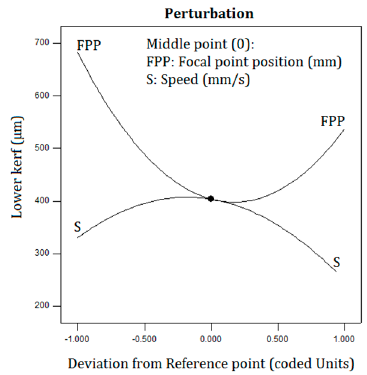
Figure 10. Perturbation plot of bottom kerf width.